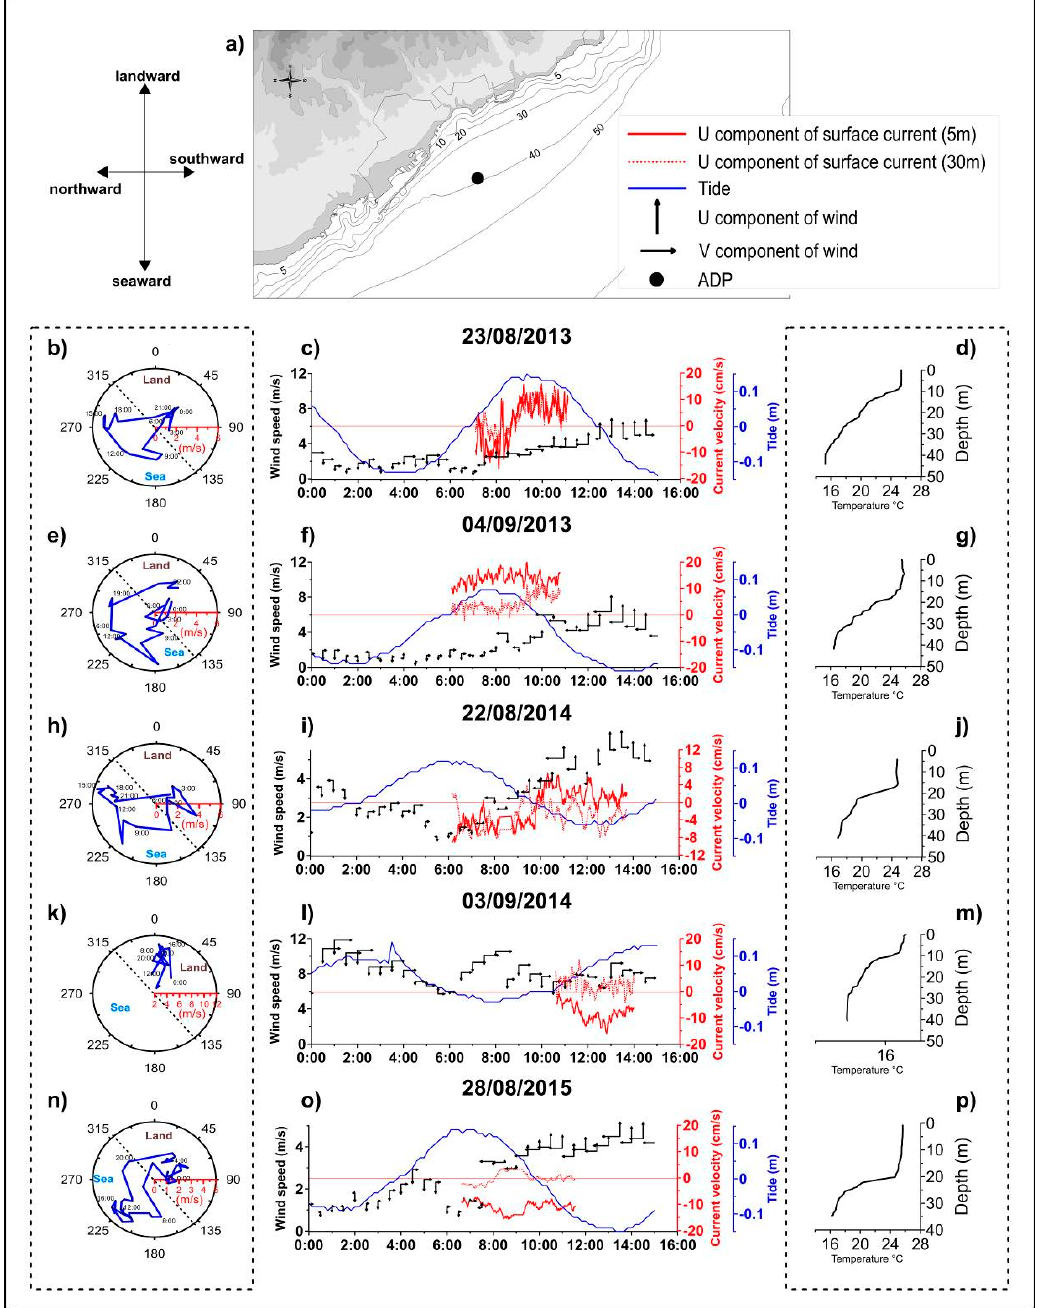
Figure 6. ( a ) Station location scheme along the coast. Wind hodograph ( b , e , h , k , n ) and ( d , g , j , m , p ) temperature profile along the water column. ( c , d , f , i , l ) U current component at 5 m (red line) and U current component at 30 m (red dots line), wind components (black arrows), and tide (blue line) for the survey days.